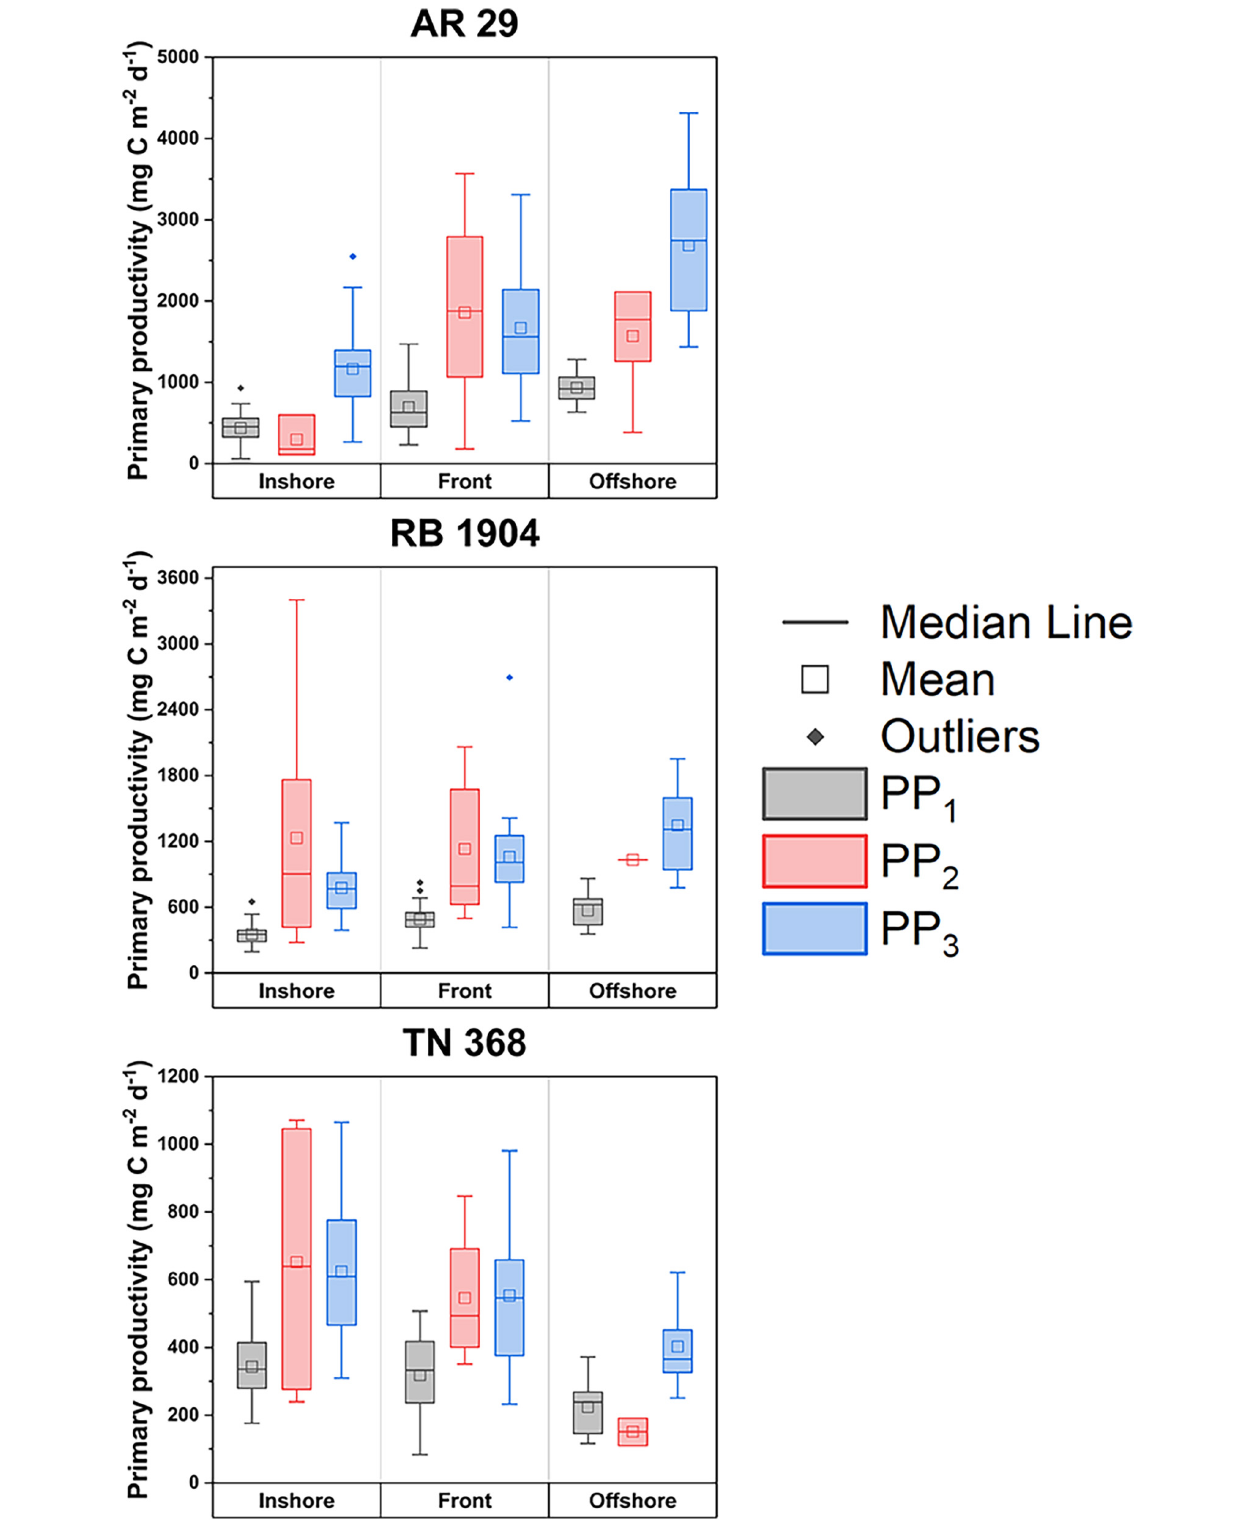
FIGURE 6 | The distribution of average primary productivity at stations inshore of the front, near the front, and offshore of the front within the three cruises. The dots outside of the boxes are extreme values that were not included in the means. Error bars represent the standard deviations.